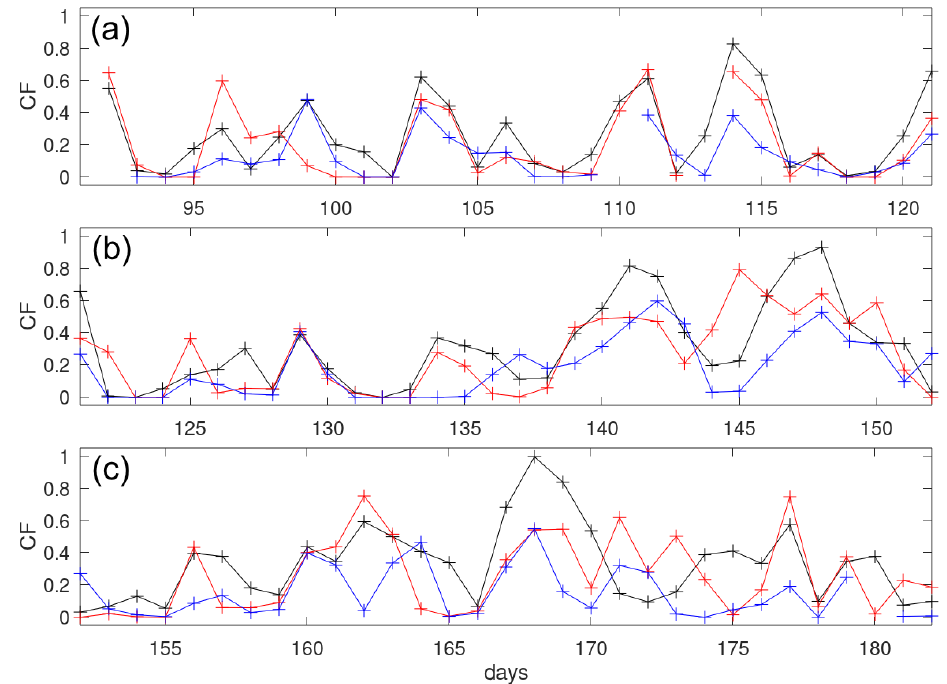
Figure 5. Averages of CF for each 30 h period for the ceilometer (black), RAMS (red) and WRF (blue) for each month: ( a ) April, ( b ) May, and ( c ) June.